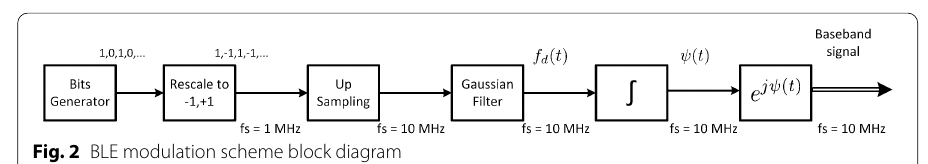
Fig. 2 BLE modulation scheme block